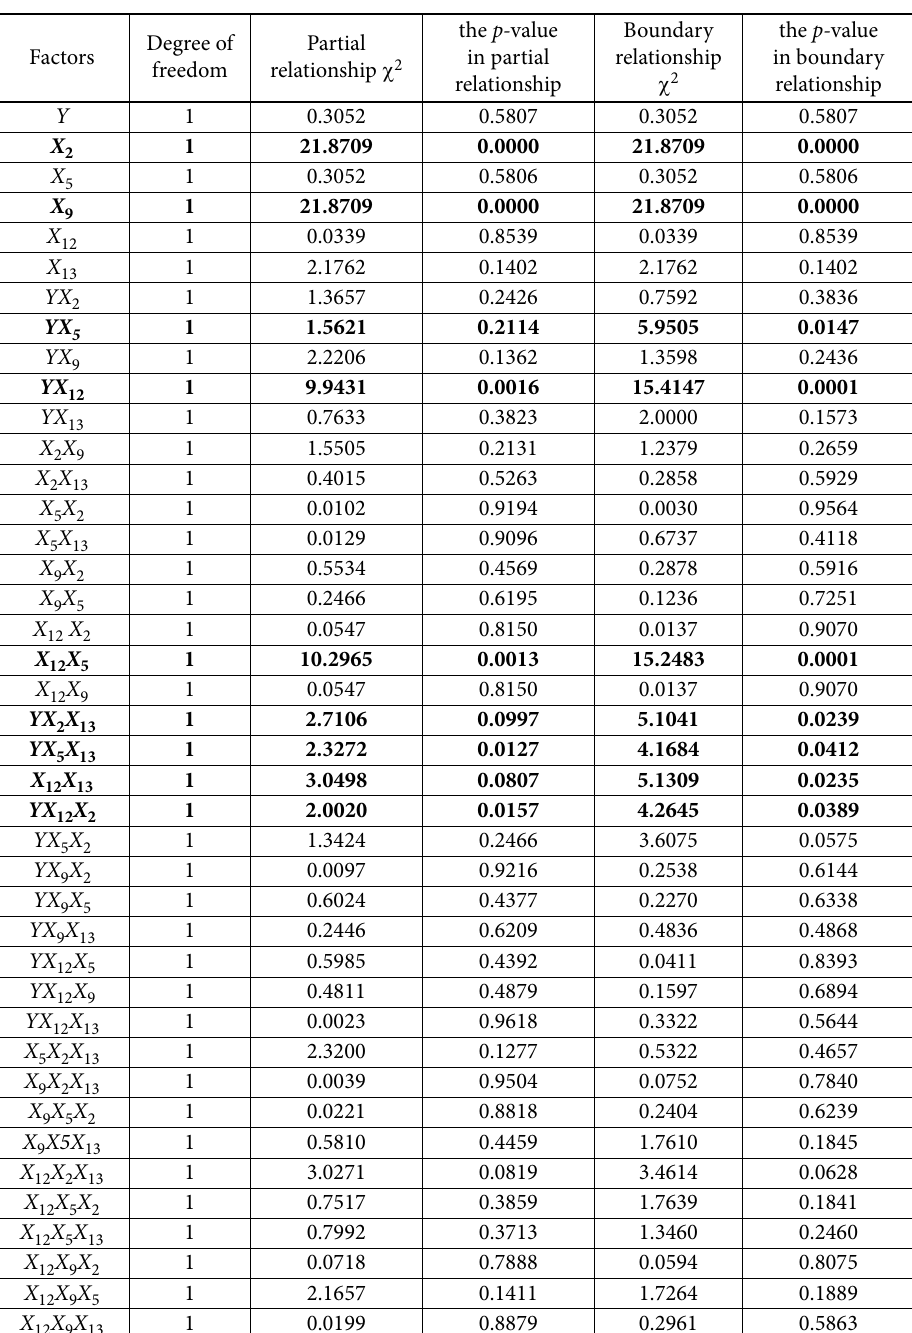
Table 4. Excerpts from the results of partial and boundary tests between variables: Y, X 2 , X 5 , X 9 X 12 ,